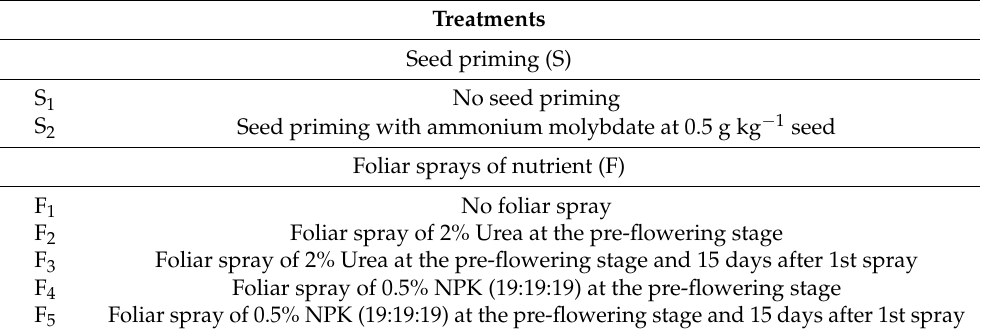
Table 2. Treatment details of the